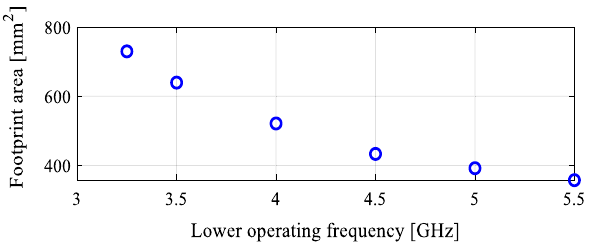
Figure 5. Trade-off designs for the CP antenna of Fig. 4: minimum attainable footprint area versus lower end of the operating bandwidth (minimum value of the upper end equals 7.5 GHz for all cases).